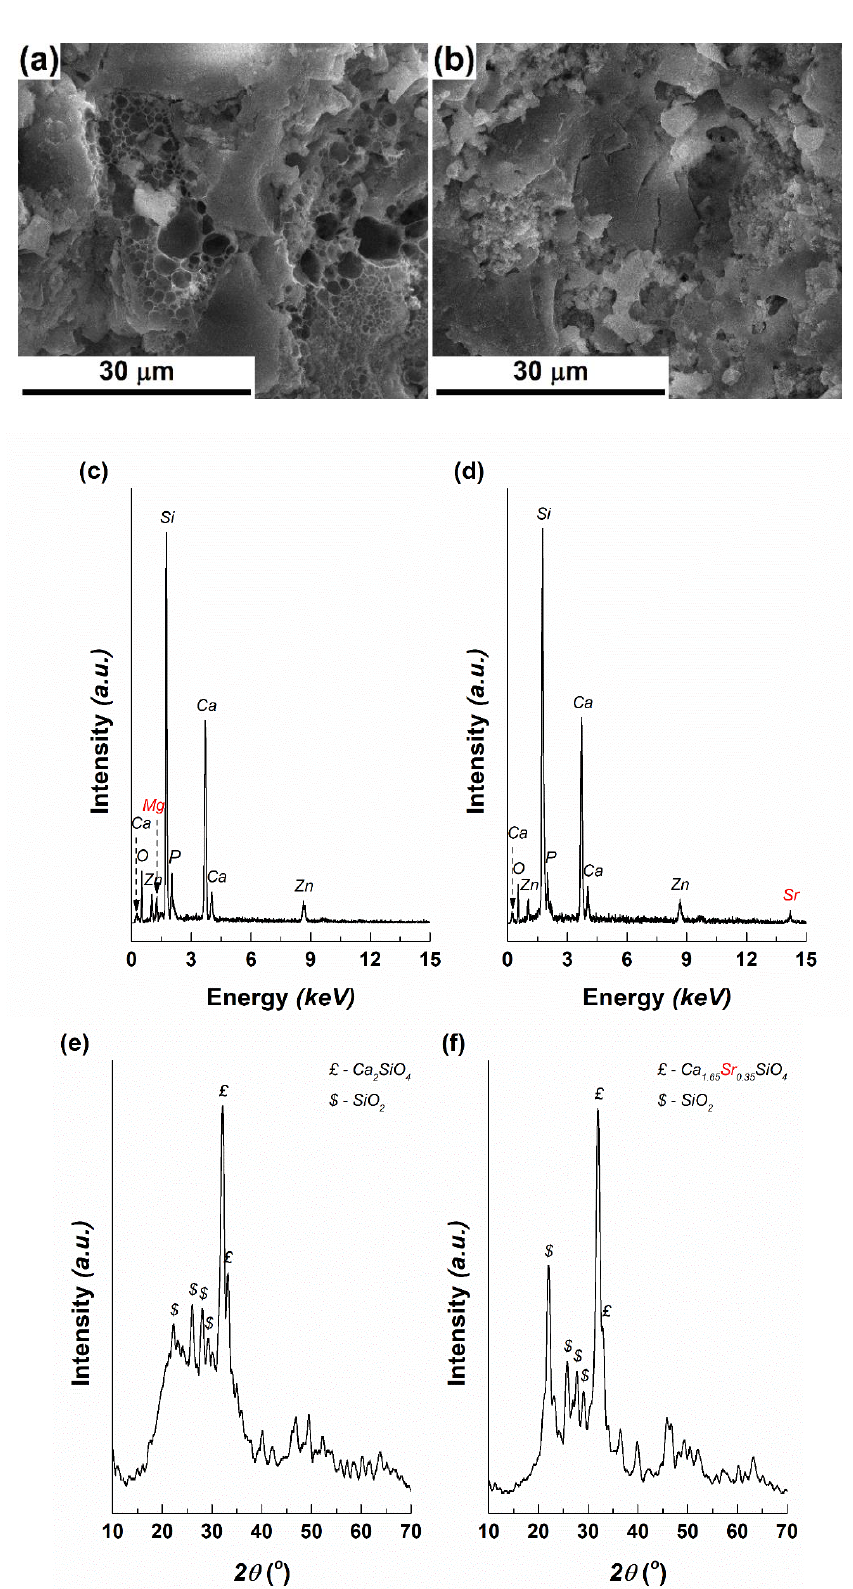
Figure 1. SEM images of: ( a ) Target-Mg and ( b ) Target-Sr, EDX spectra of: ( c ) Target-Mg and ( d ) Target-Sr and XRD patterns of: ( e ) Target-Mg and ( f ) Target-Sr.